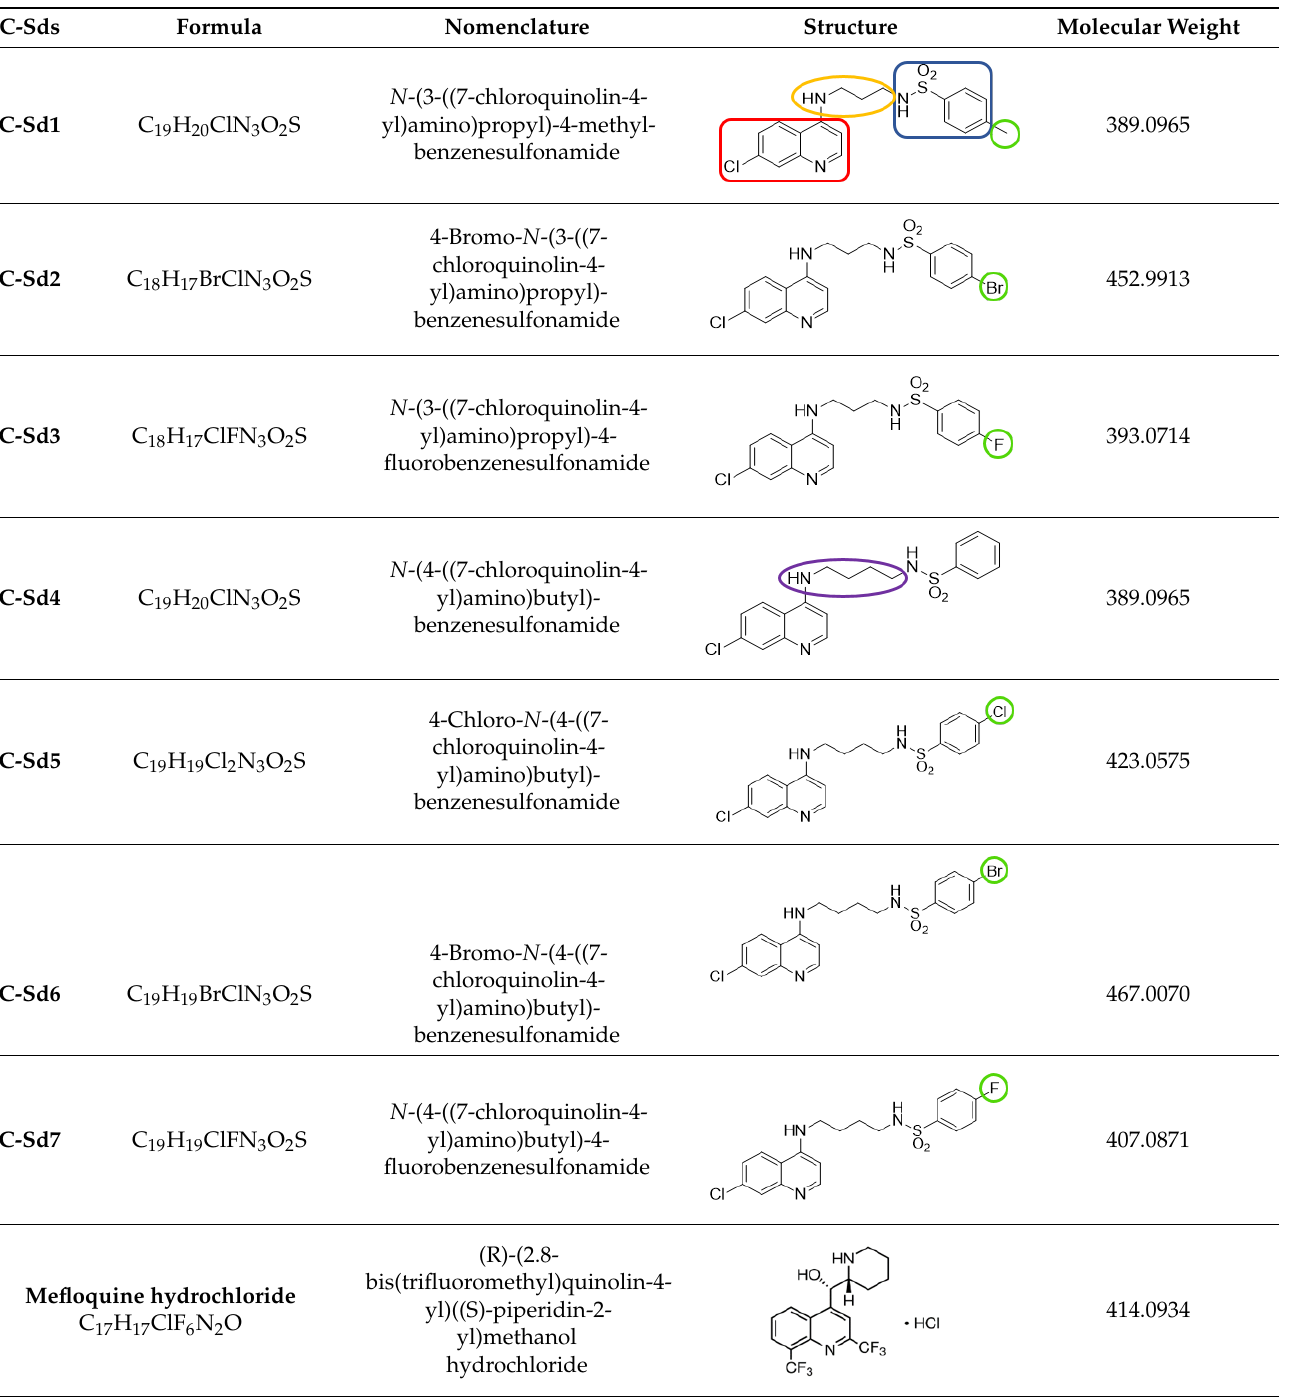
Table 1. Chemical characteristics of hybrid compounds derived from the chloroquine and sulfadoxine drugs.(C-Sds) and mefloquine hydrochloride.